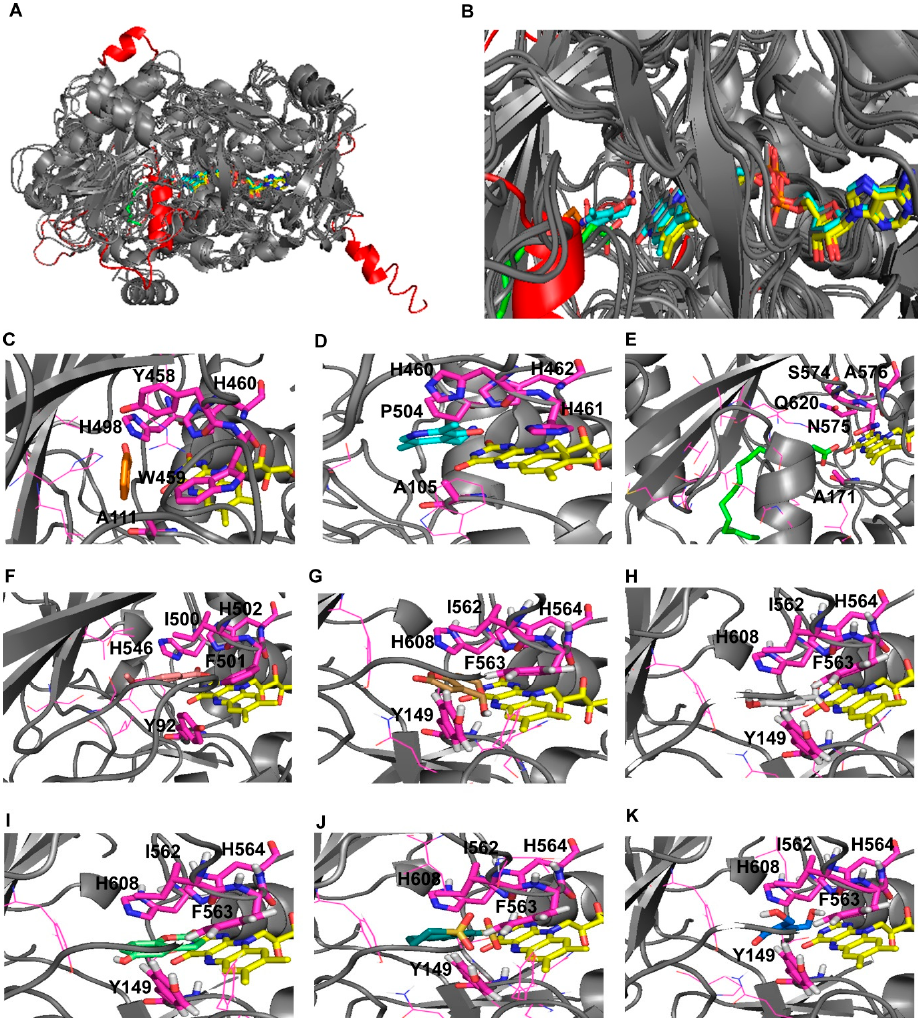
Figure 4. Comparative analysis for identifying the best grid box for Virtual Screening analysis. P. expansum GMC comparative model is reported in grey cartoon. FAD is reported in yellow sticks. Panel A : superimposition of P. expansum GMC oxidoreductase 3D model and crystallized homologous proteins substrates, inhibitors and FAD cofactor. Panel B : exploded view of the FAD binding region. Panel C : benzaldehyde (HBX) reported in orange sticks representation crystallized within “6lqy.pdb”. Panel D : 4-(aminomethyl)-5-(hydroxymethyl)-2-methylpyridin-3-ol (PMX) reported in cyan sticks representation, crystallized within “4ha6.pdb”. panel E palmitic acid (PLM) reported in green sticks representation, crystallized within “5ncc.pdb”. Panel F : p -anisic acid (ANN) reported in light pink sticks representation, crystallized within “5oc1.pdb”. patulin reported in light brown sticks representation (panel G ); p -anisic acid reported in light gray sticks representation (panel H ); 6-hydroxycoumarin reported in light green sticks representation (panel I ); meticrane reported in green cyan sticks representation (panel J ); ( E )-ascladiol reported in blue sticks representation (panel K ) within the P. expansum GMC oxidoreductase as obtained from docking analyses. Residues numbering of “6lqy.pdb”, shown in panel C , and residues numbering of the “6lqy” fasta sequence, shown in Figure 2, differs of 6 units (i.e., A111; Y458, W459, H460 and H498 reported in panel D corresponds to A117; Y464, W465, H466 and H504 reported in Figure 2, in blocks 3, 8 and 10, respectively). Residues numbering of “4ha6.pdb”, shown in panel D , and residues numbering of the “4ha6” fasta sequence, shown in Figure 2, differs of 16 units (i.e., A105; H460, H461, H462 and P504 reported in panel D corresponds to A89; H444, H445, H446 and P488 reported in Figure 2, in blocks 3, 8 and 10, respectively). Residues numbering of “5ncc.pdb” chain A, shown in panel E , and residues numbering of the “5ncc” fasta sequence, shown in Figure 2, differs of 60 units (i.e., A171; N575 and Q620 reported in panel E corresponds to A111; N515 and Q560 reported in Figure 2, in blocks 3, 8 and 10, respectively). Residues numbering of “5oc1.pdb”, shown in panel F , and residues numbering of the “5oc1” fasta sequence, shown in Figure 2, differs of 1 unit (i.e., Y92; I500, F501, H502 and H546 reported in panel D corresponds to Y91; I499, F500, H501 and H545 reported in Figure 2, in blocks 3, 8 and 10,